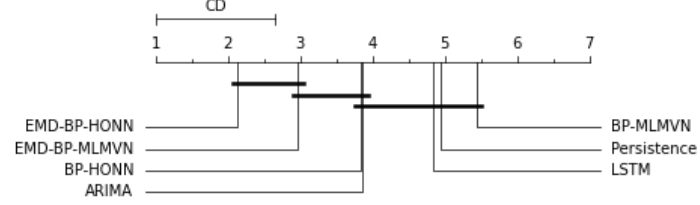
Figure 9. Critical difference graph for Nemenyi